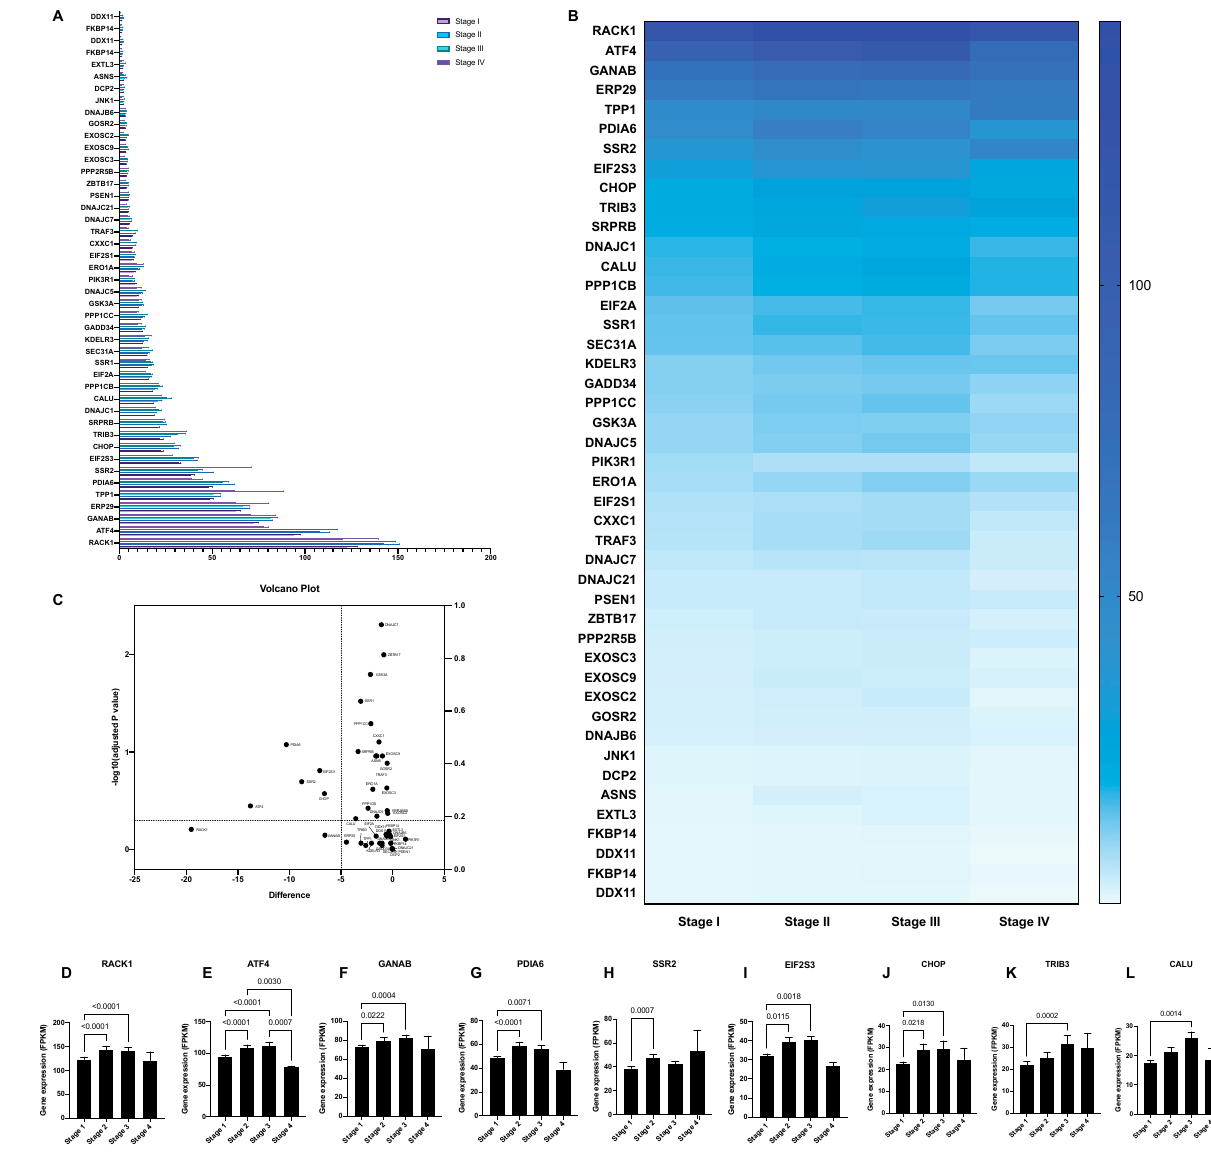
Figure 4. The mRNA expression of unfavorable UPR-associated markers per HCC stage shown in a bar chart ( A ), a heatmap ( B ), and a volcano plot ( C ). Markers with statistically significant expression levels between the different stages are shown as individual bar charts ( D – L ). p -values of <0.05 were considered statistically significant.